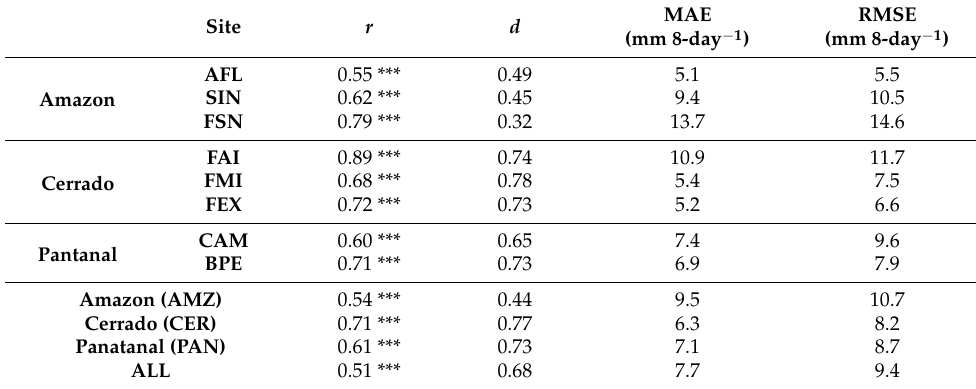
Figure 3. Annual and seasonal mean (±95% Confidence Interval) of measured (ET Measured ) and estimated (ET MODIS ) 8-day evapotranspiration (mm 8-day − 1 ) in each site in the Amazon (AMZ), Cerrado (CER) and Pantanal (PAN) sites and in all sites (ALL). The shading area refers to the mean ET in the three biomes of Mato Grosso. Table 2. Summary of Pearson’s correlation coefficient (r), Willmott agreement index (d), Mean Absolute Error (MAE; mm 8-day − 1 ), and Root Mean Square Error (RMSE; mm 8-day − 1 ) of the measured and estimated evapotranspiration (i.e., ET Measured and ET MODIS , respectively) accumulated every 8 days (mm 8-day − 1 ) for the entire period of the study in each site in the Amazon (AMZ), Cerrado (CER), and Pantanal (PAN) sites and all sites collectively (ALL). Values accompanied by (***) indicate p -value <